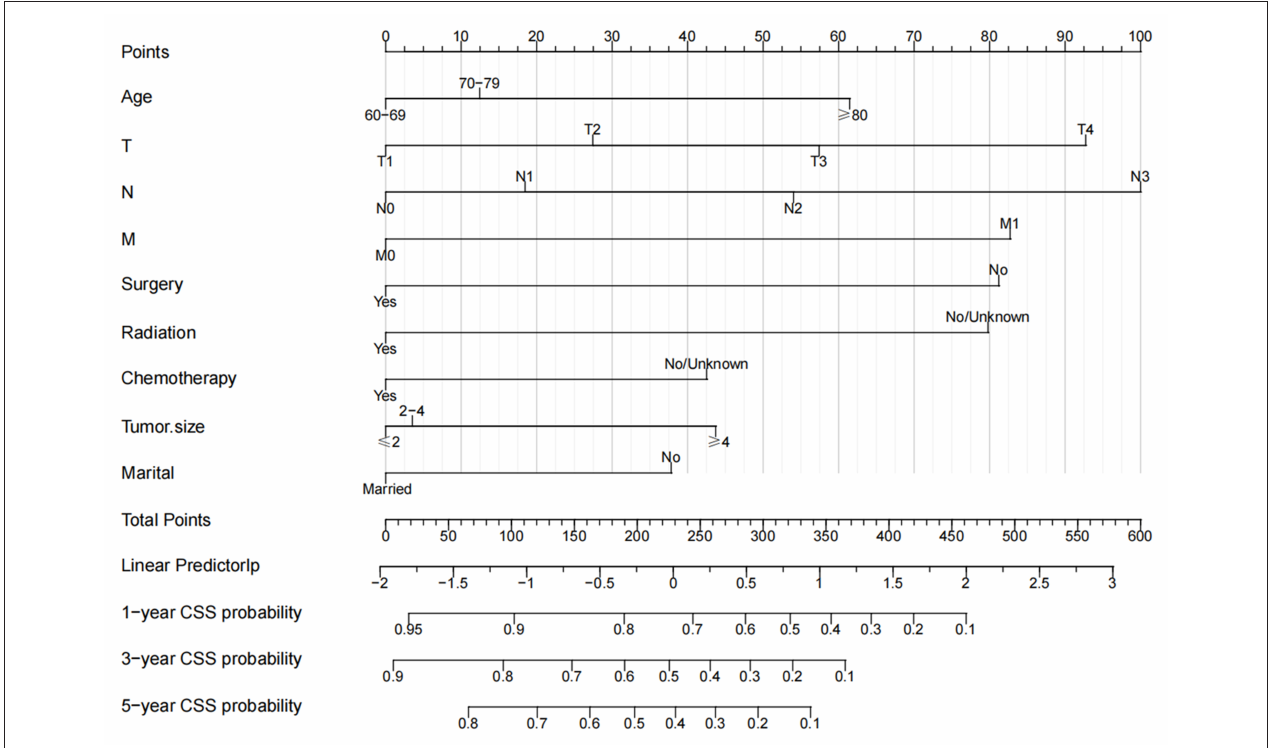
FIGURE 2 | Nomogram for 1-, 3-, and 5-year CSS of elderly patients with HPSCC.